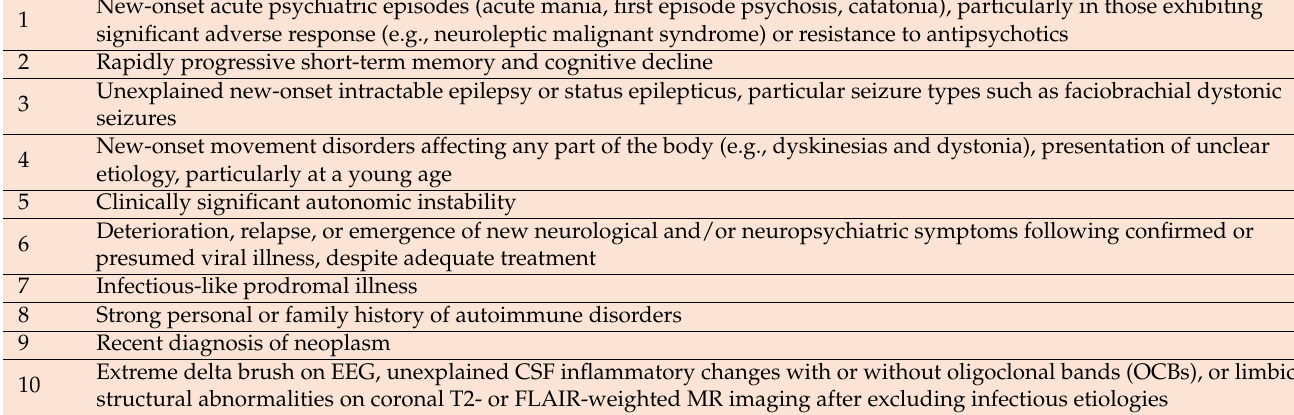
Table 2. Red flags of possible autoimmune encephalitis in individuals with unexplained neuropsy- chiatric